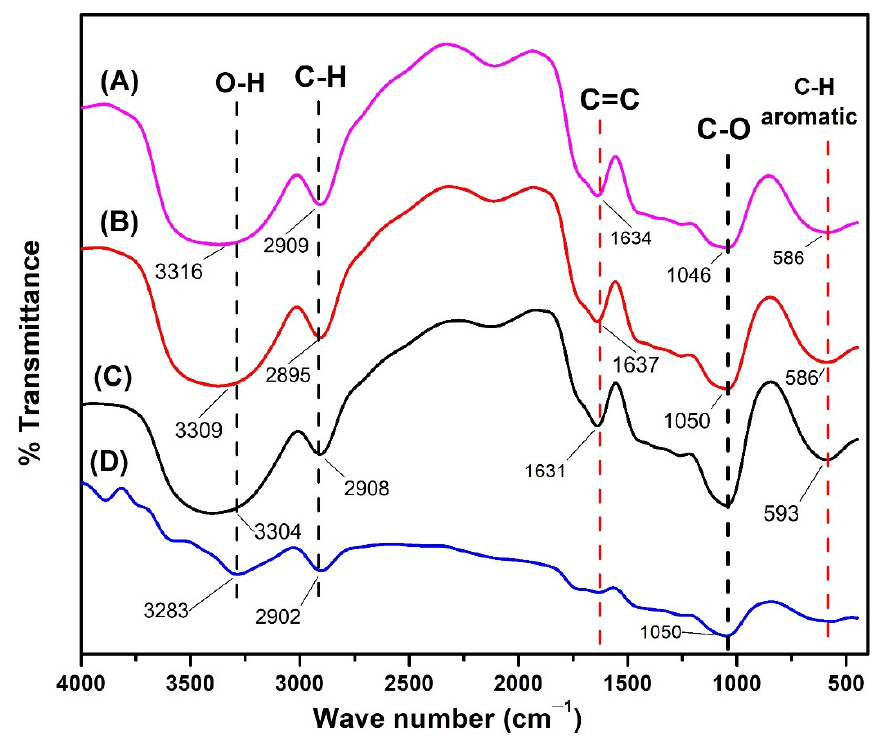
Figure 11. FTIR spectrum after UV-Vis radiation treatment on ( A ) impregnated mangium wood with 5% TiO 2 nanoparticle, ( B ) impregnated mangium wood impregnated with 1% TiO 2 nanoparticle, ( C ) untreated mangium wood without radiation, ( D ) untreated mangium wood with radiation.